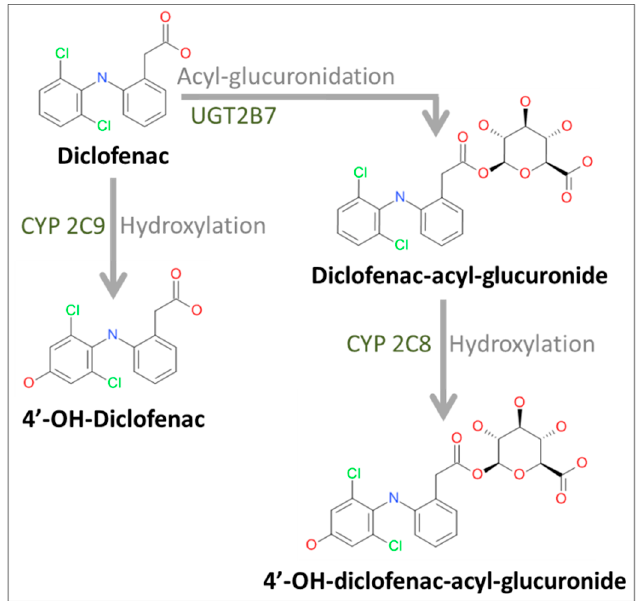
Figure 2. Diclofenac pathways under investigation. The parent drug diclofenac can be hydroxylated by cytochrome P450 (CYP) isoform CYP2C9 to form 4 ′ -OH-diclofenac or glucuronidated by uridine diphosphate (UDP)-glucuronosyltransferase-2B7 (UGT2B7) to form diclofenac-acyl-glucuronide,